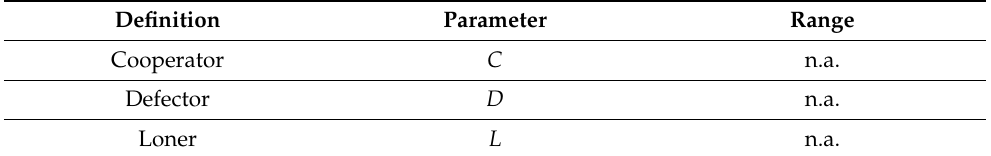
Table 2. Strategies of potential players ( C : cooperation; D : defection; L : no participation).